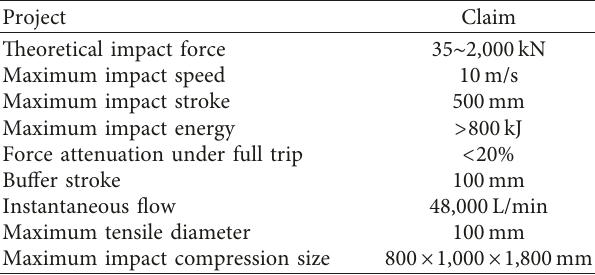
Table 1: Working parameters of impact test machine.